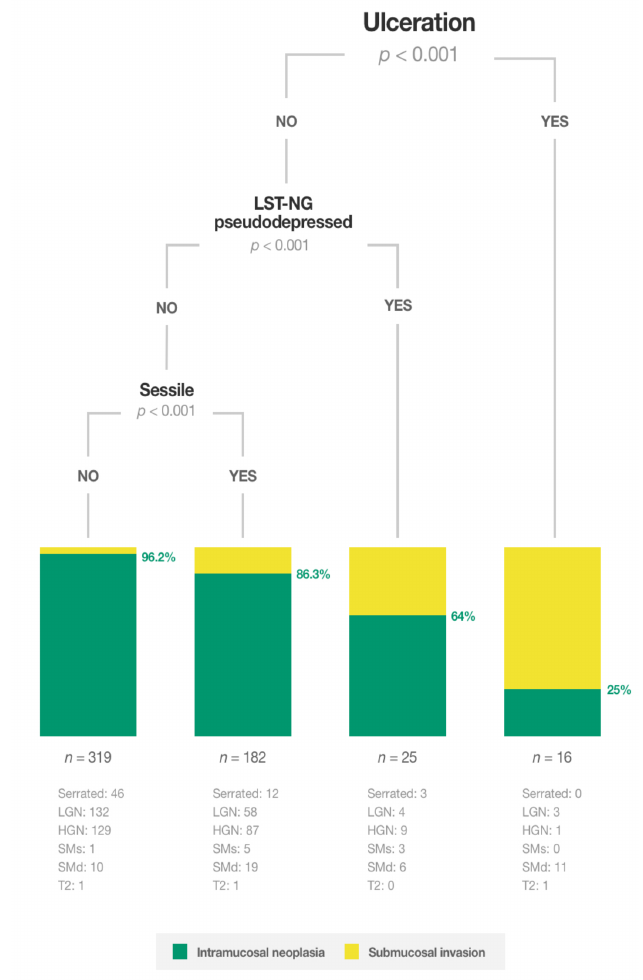
Figure 1. Conditional inference tree for identifying intramucosal